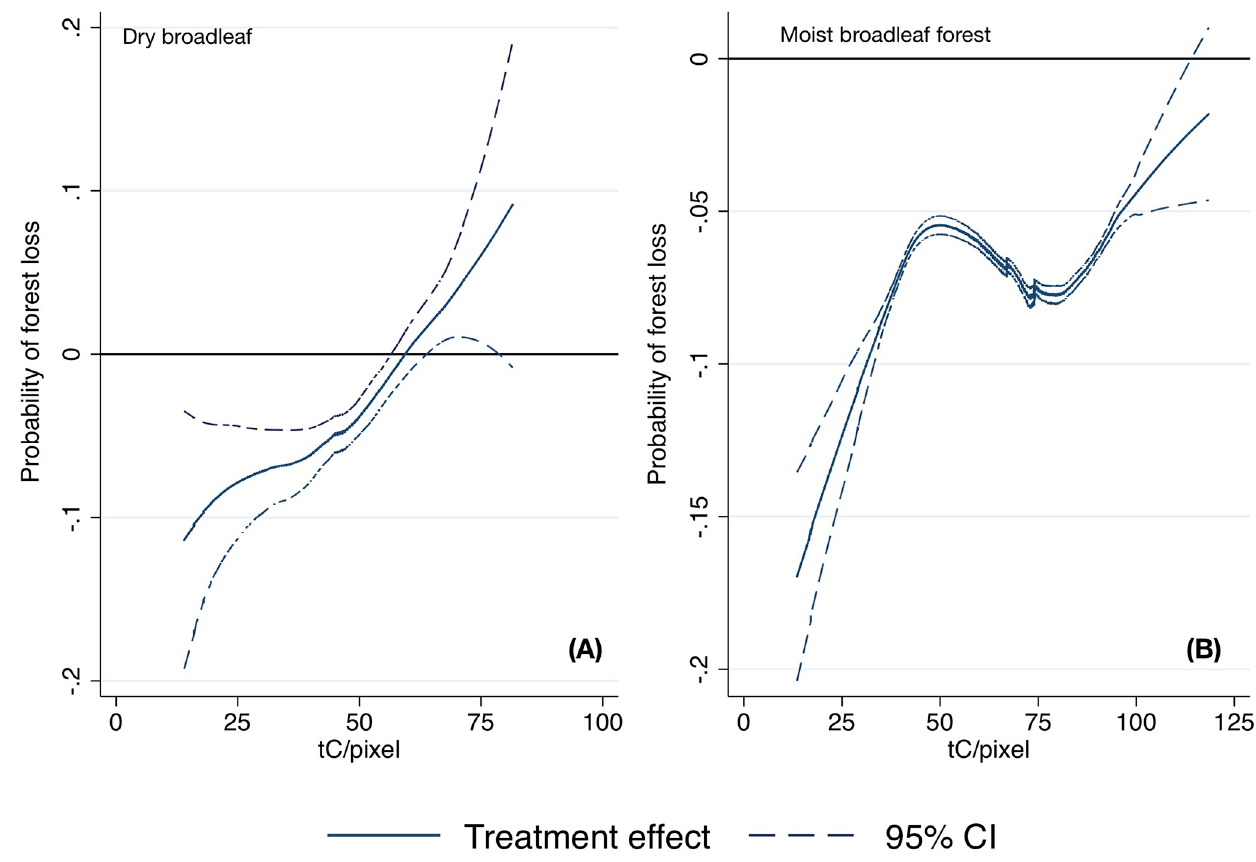
Fig 3. Results from the post-matching partial linear models comparing pixels under protected areas (treatment) to observationally similar non-protected pixels regardless of tenure for (A) dry broadleaf forests, and (B) moist broadleaf forests. Negative values indicate that a treatment (presence of a protected area) was effective in reducing forest loss for a given baseline biomass value; the estimate is statistically significant if the confidence intervals do not span the 0 horizontal